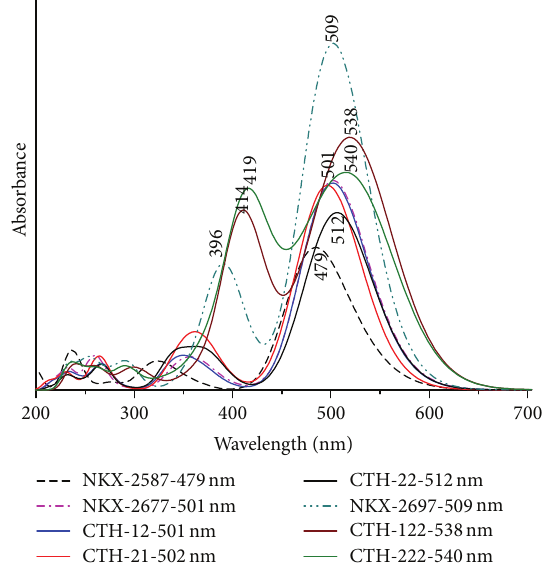
Figure 2: Ultraviolet-visible absorption spectra at M06-2X/6- 311G(d) level of theory. Acetonitrile was considered as